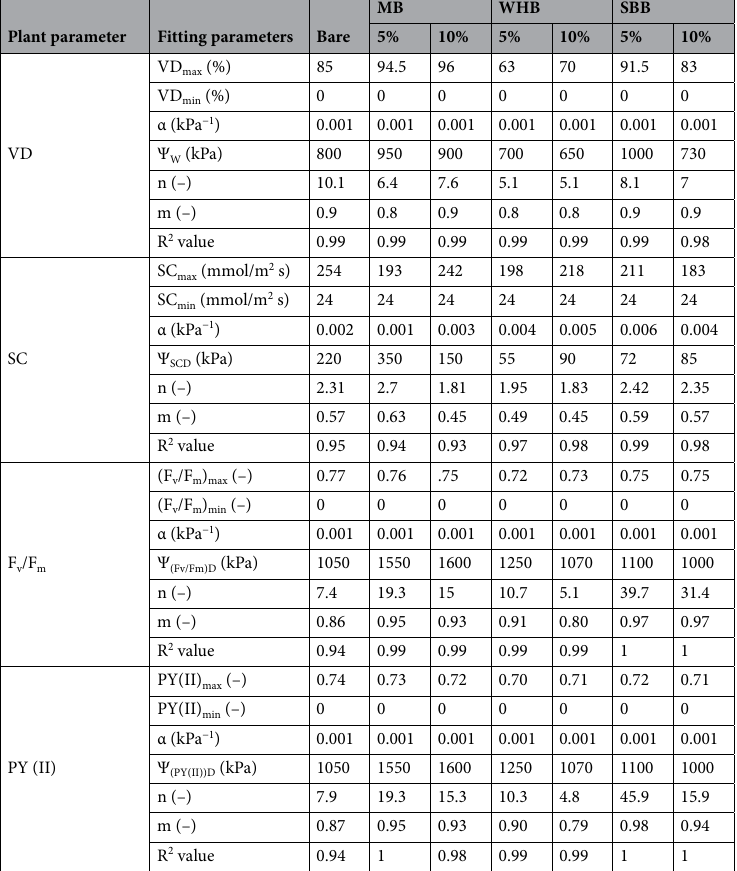
Table 4. Fitting parameters of plant parameter vs suction curve obtained after fitting the correlation proposed by Gadi et al. 9 .